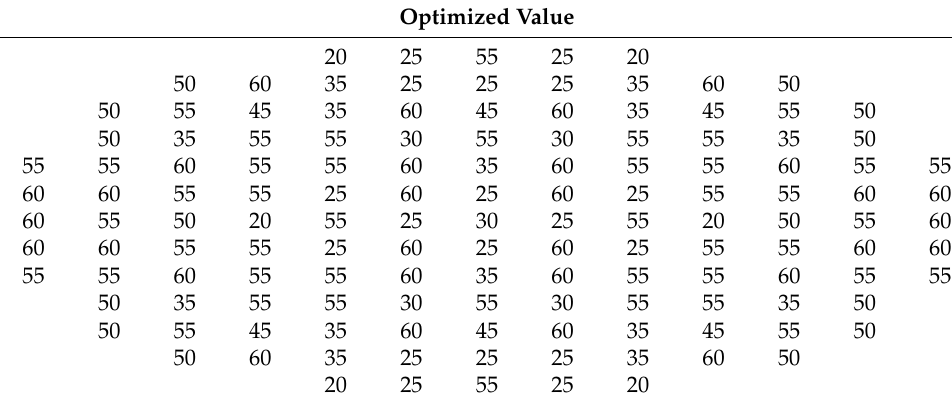
Table 1. Optimized height (h1–h137) of the 137 DR bars (unit: millimeters).